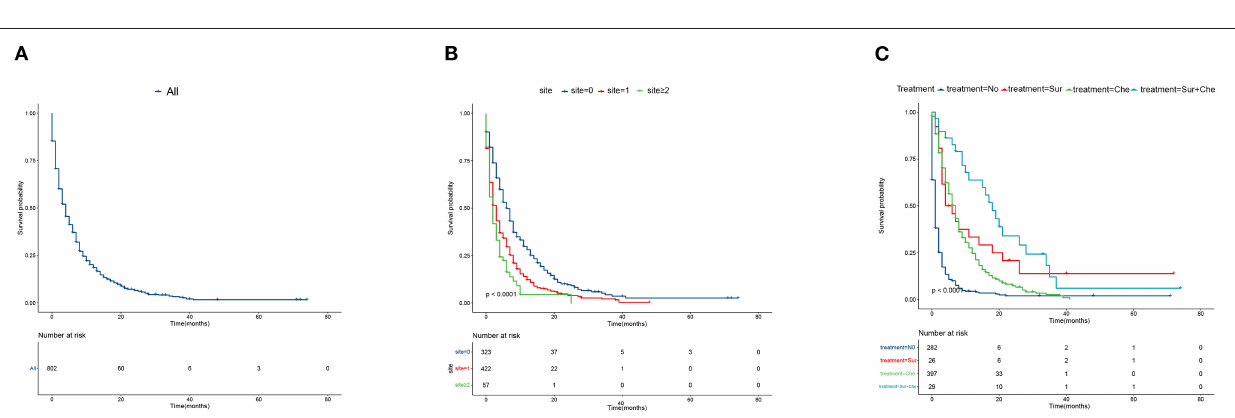
FIGURE 3 | Kaplan–Meier analysis of overall survival among pancreatic cancer patients with lung metastasis at diagnosis. (A) overall, (B) stratified by the extent of extrapulmonary metastatic disease, and (C) stratified by type of treatment.